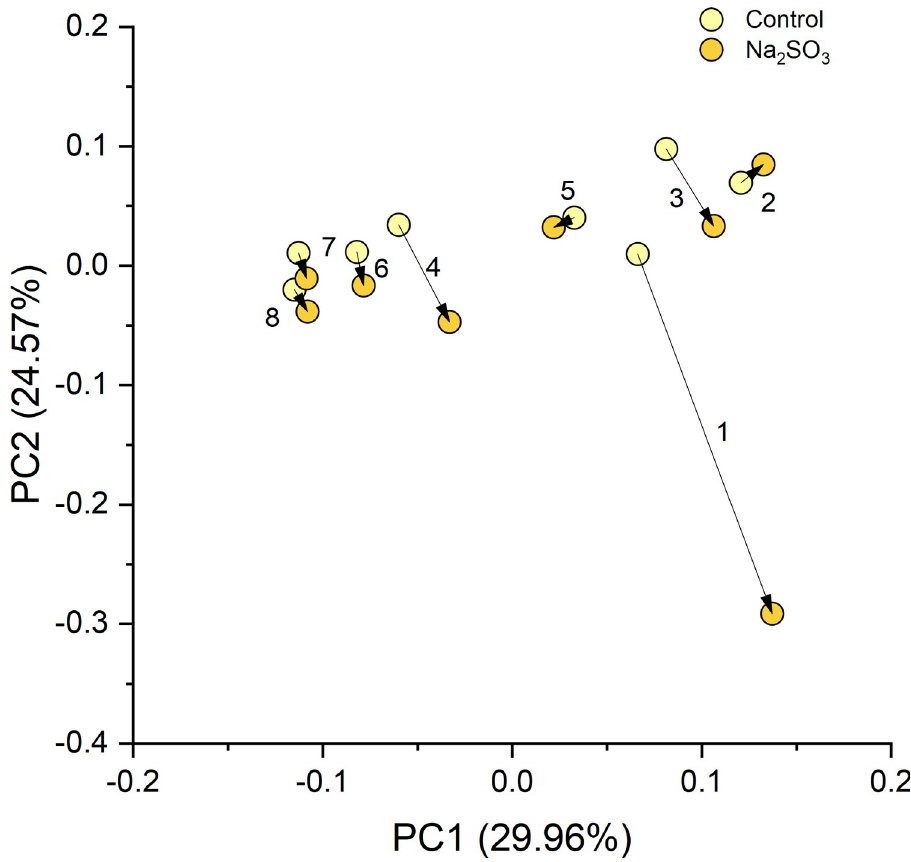
Fig 9. Beta diversity of F2 Na ₂ SO ₃ treated samples. The PCA of all the ASVs from the control and Na 2 SO 3 treated F2 samples, show consistent directions of changes in the microbial communities under the treatment of Na 2 SO 3 .